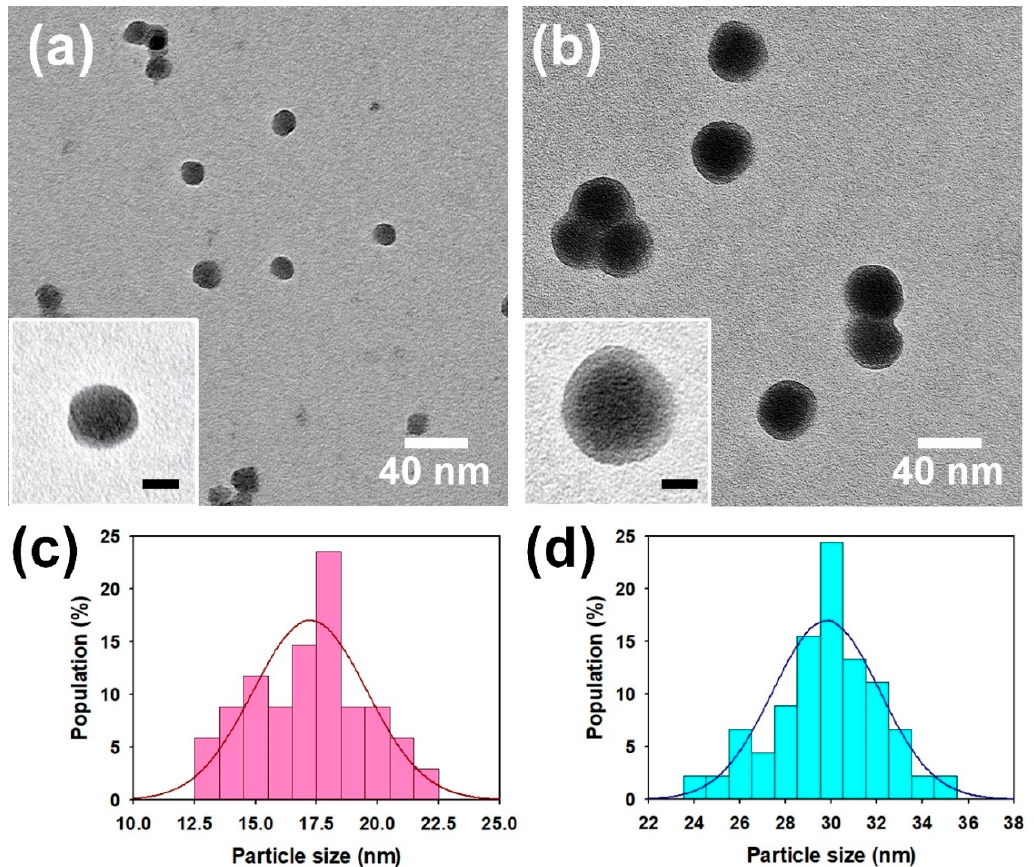
Figure 2. Transmission electron microscope (TEM) images of SiO 2 -PPy core-shell NPs with ( a ) 12 nm and ( b ) 22 nm SiO 2 NPs prepared by the ex situ method. Histograms for particle size distribution for SiO 2 -PPy core-shell NPs with ( c ) 12 nm and ( d ) 22 nm SiO 2 NPs prepared by ex situ method. The scale bars of inset images correspond to 10 nm. The number of core-shell NPs analyzed were 100 each.